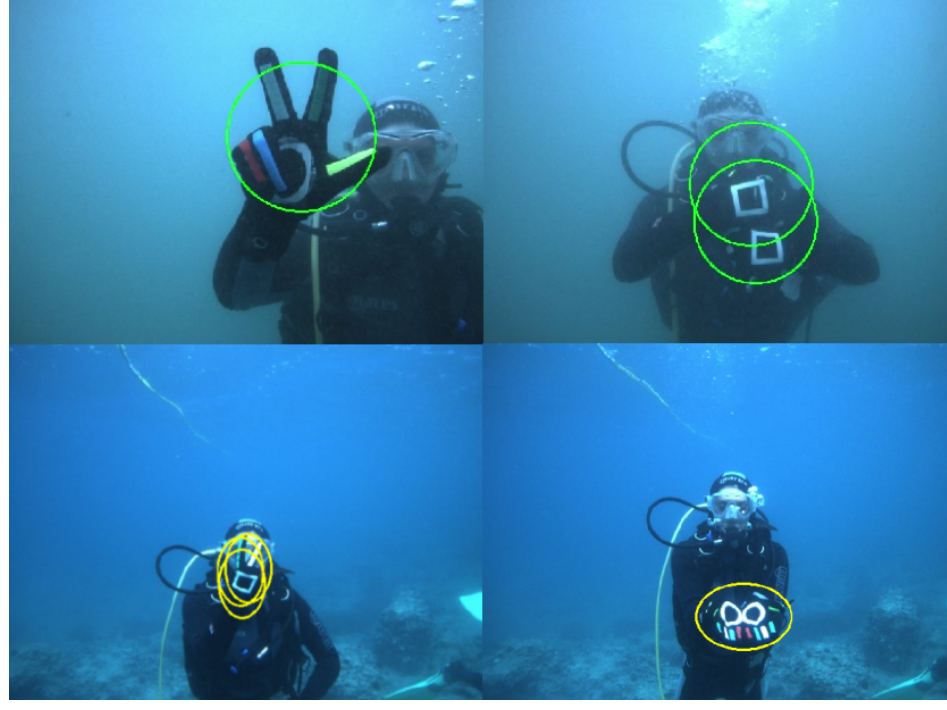
Figure 7. Detected gestures, from the top left, clockwise: take a photo, carry equipment, start communication, and go to the boat.